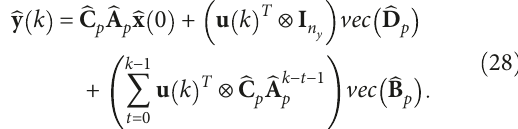
Figure 2: Closed-loop subspace identi fi cation